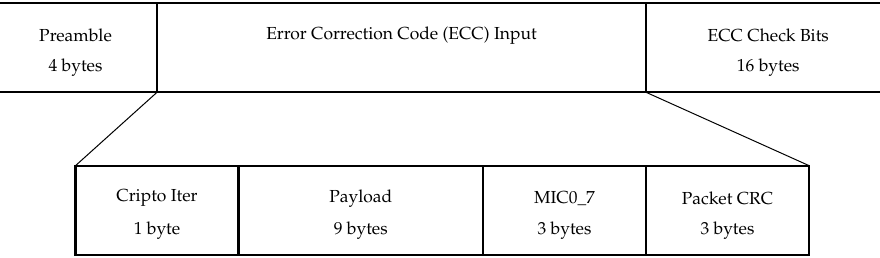
Figure 3. Downlink frame structure in